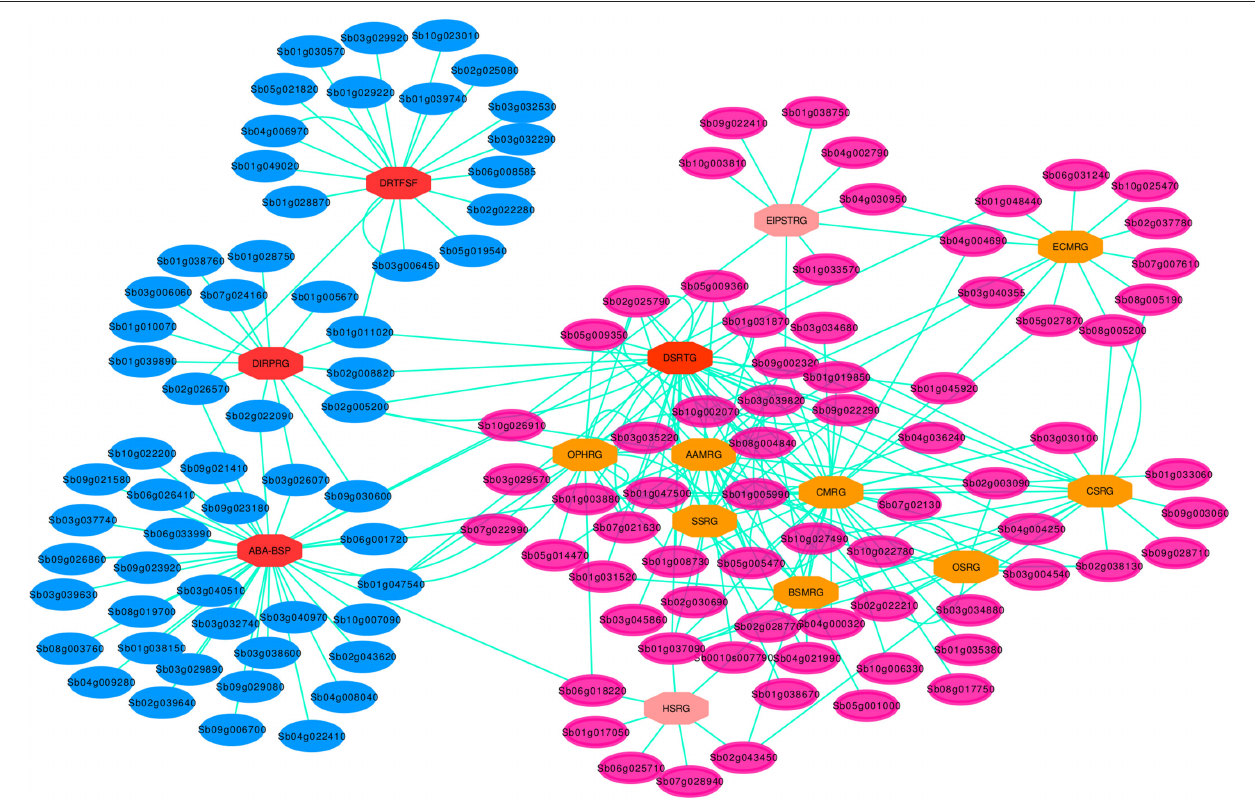
FIGURE 5 | Drought specific PPI sub-network for the key genes involved in the pathway cross-talk network. Blue elliptic nodes represent drought specific pathway genes, MDSGs, while the rose elliptic nodes denote the rest of DRGs, non-MDSGs. The ellipse shape of the nodes shows that all the genes are involved in the drought associated cross-interaction network. Each octagonal node indicate one of the 14 set of pathway DSRhub gene and the color of the octagonal nodes indicate the size of interacting geneset, such that the brighter the color, the greater the number of interacting set of genes. For 14 nodes each represented by DSRhub genes, a total of 266 nodes were denoted by interacting genes that are involved in the pathway defined cross-talking relations.